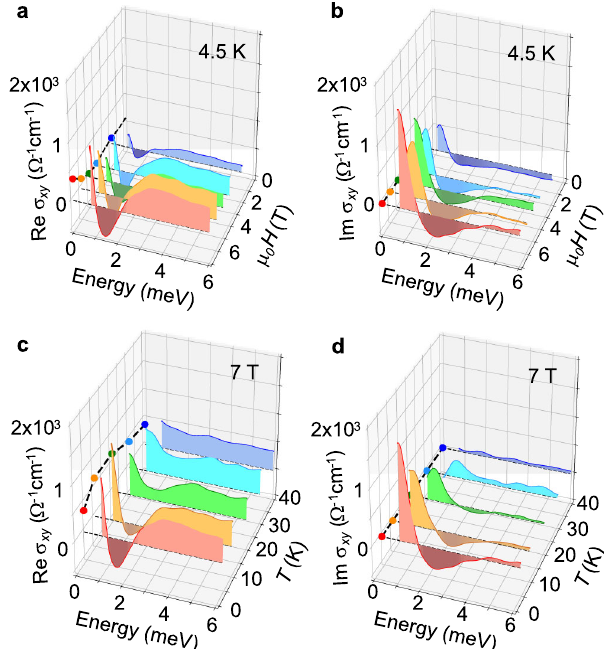
Fig. 2 Terahertz Hall conductivity spectra of MnGe thin fi lm. a , b The magnetic- fi eld dependence of the real ( a ) and imaginary ( b ) parts of the Hall conductivity spectra ( σ xy ( ω )) at 4.5 K. The spectra are measured at 2, 4, 5, 6, and 7 T. c , d The temperature dependence of the real ( c ) and imaginary ( d ) parts of the Hall conductivity spectra at 7 T. The spectra are measured at 4.5, 10, 20, 30, and 40 K. Filled circles at zero frequency are the DC values acquired from the transport